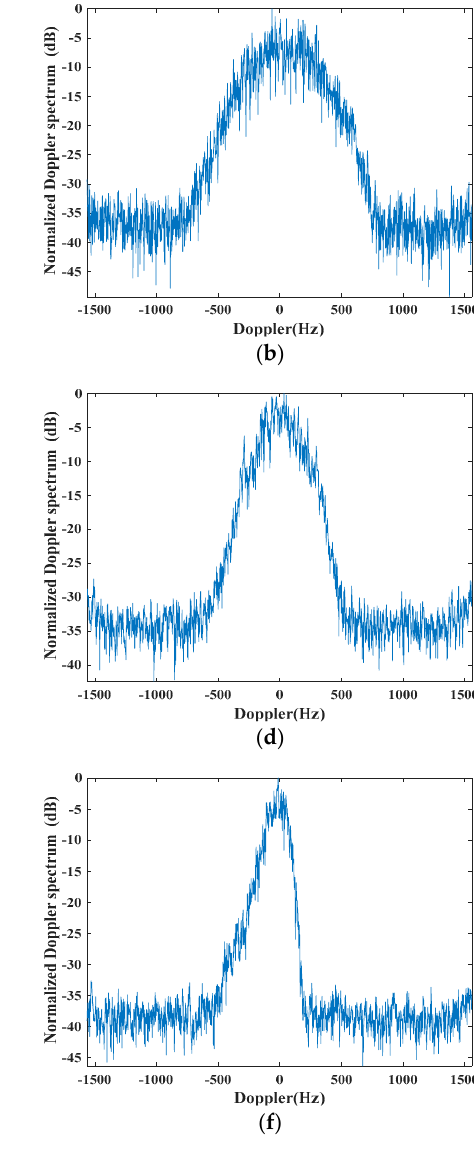
Figure 7. Range Doppler images and normalized Doppler spectra in different scan angles: ( a ) Original image at the 1.03 degree scan angle; ( b ) normalized Doppler spectrum for ( a ) in the central slant range; ( c ) original image at the 43.35 degree scan angle; ( d ) normalized Doppler spectrum for ( c ) in the central slant range; ( e ) original image at the 89.91 degree scan angle; and ( f ) normalized Doppler spectrum for ( e ) in the central slant range.